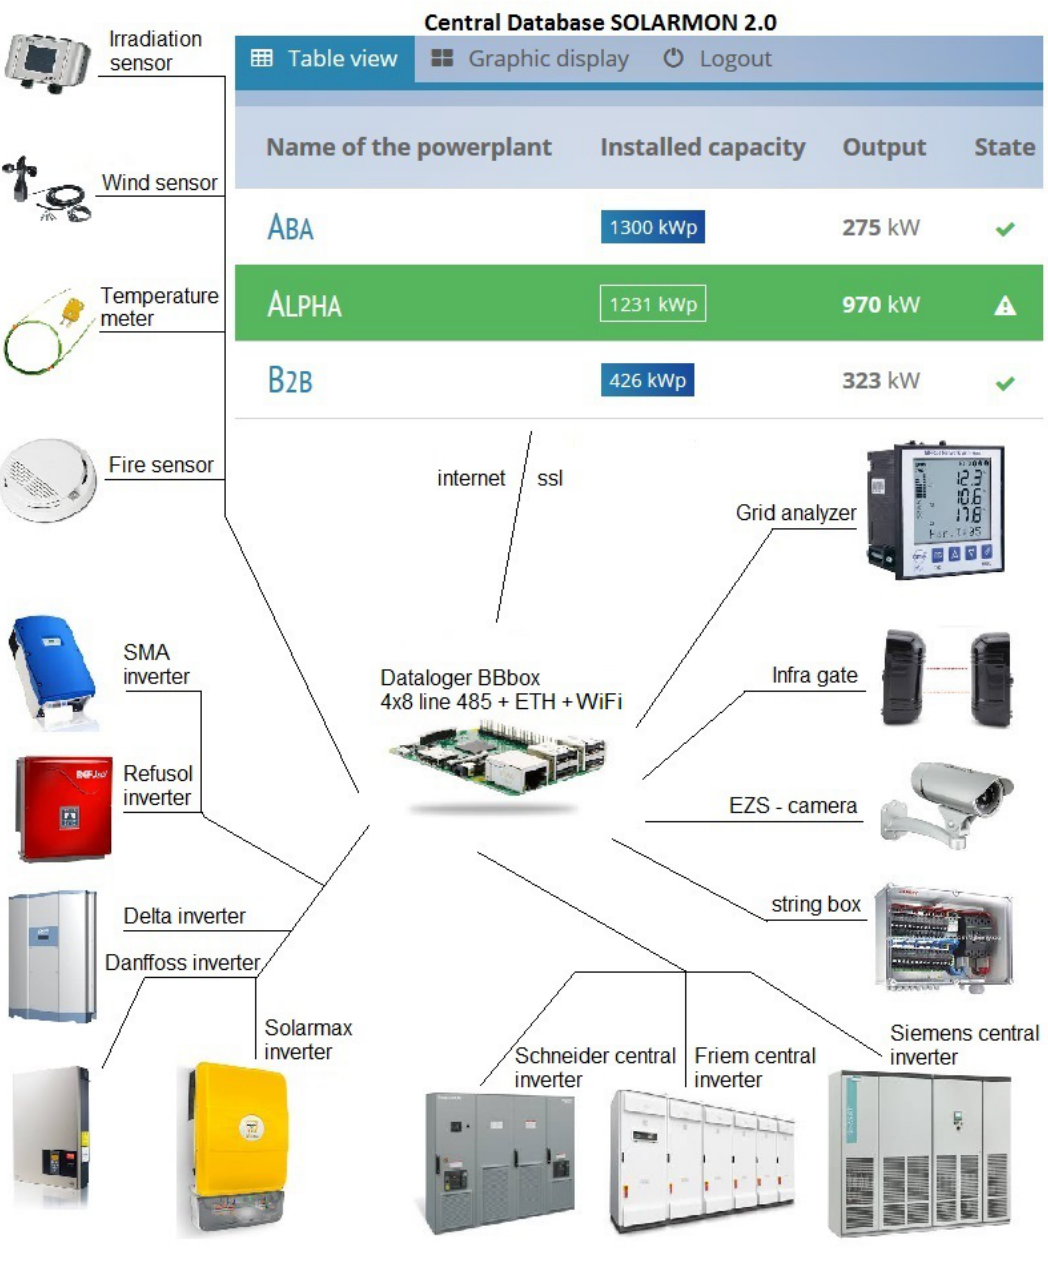
Figure 1. Scheme of the monitoring system Solarmon-2.0.